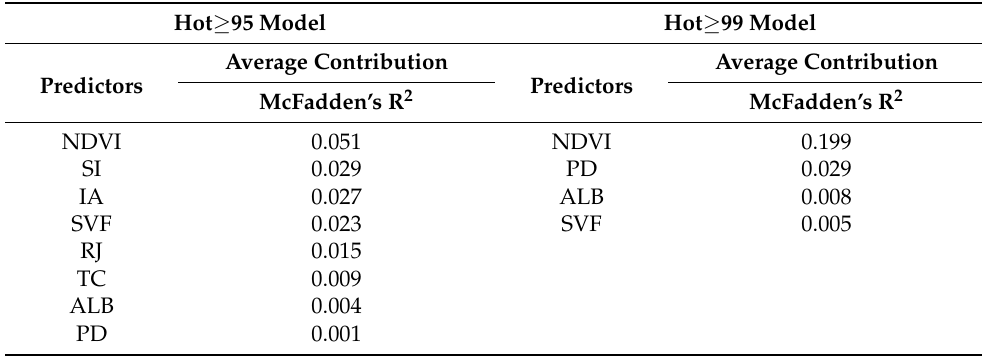
Table 9. Average contribution by predictor (General Dominance Analysis of selected Hot-spot logistic